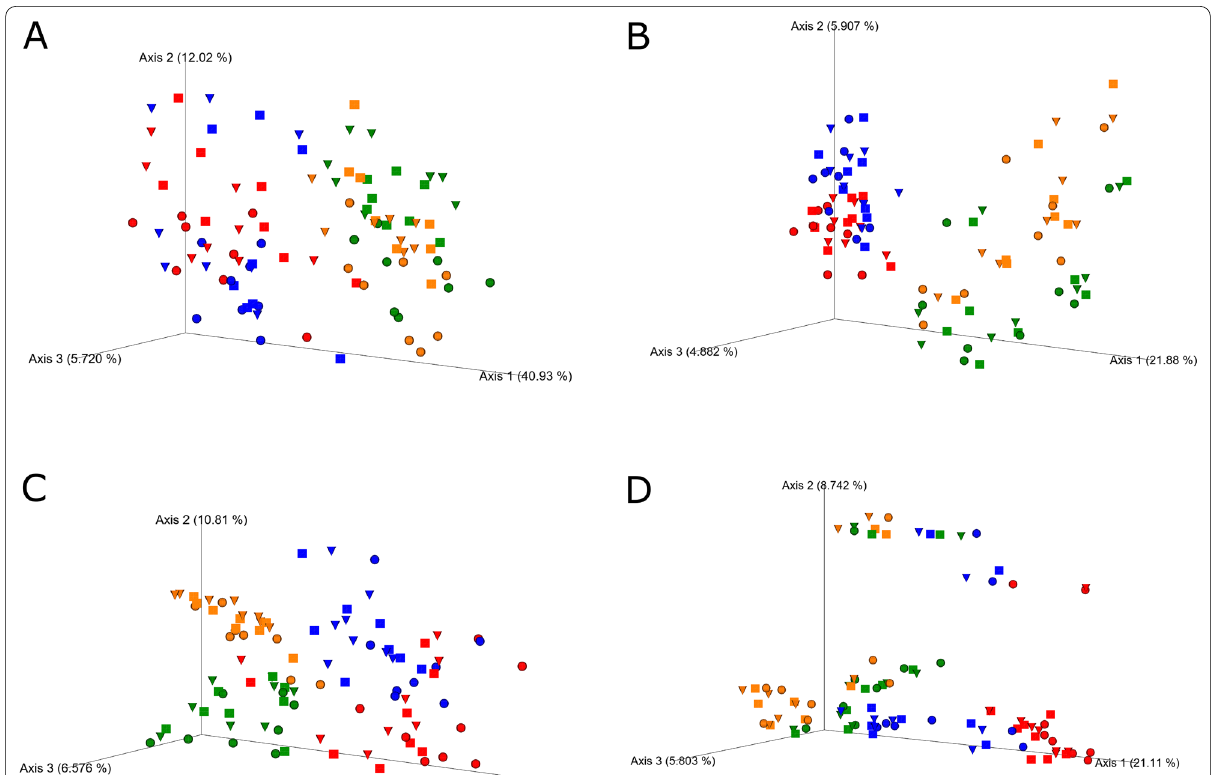
Fig. 1 Impact of methane inhibitors on the bacterial and archaeal community in rumen digesta and rumen fluid from cattle fed a control diet (CON, red), a control diet supplemented with canola oil (OIL, green), 3-NOP (3-NOP, blue), or a combination of 3-NOP and canola oil (3-NOP orange). Principle components plots are based on UniFrac distances and colored to show the impacts of time and treatment on microbiome composition. A weighted UniFrac plot of rumen fluid samples, B unweighted UniFrac plot of rumen fluid, C weighted UniFrac plot of rumen digesta, D unweighted UniFrac plot of rumen digesta. Samples taken prior to feeding are shown as circles, samples taken 6 h after feeding are shown as squares, samples taken 12 h after feeding are shown as